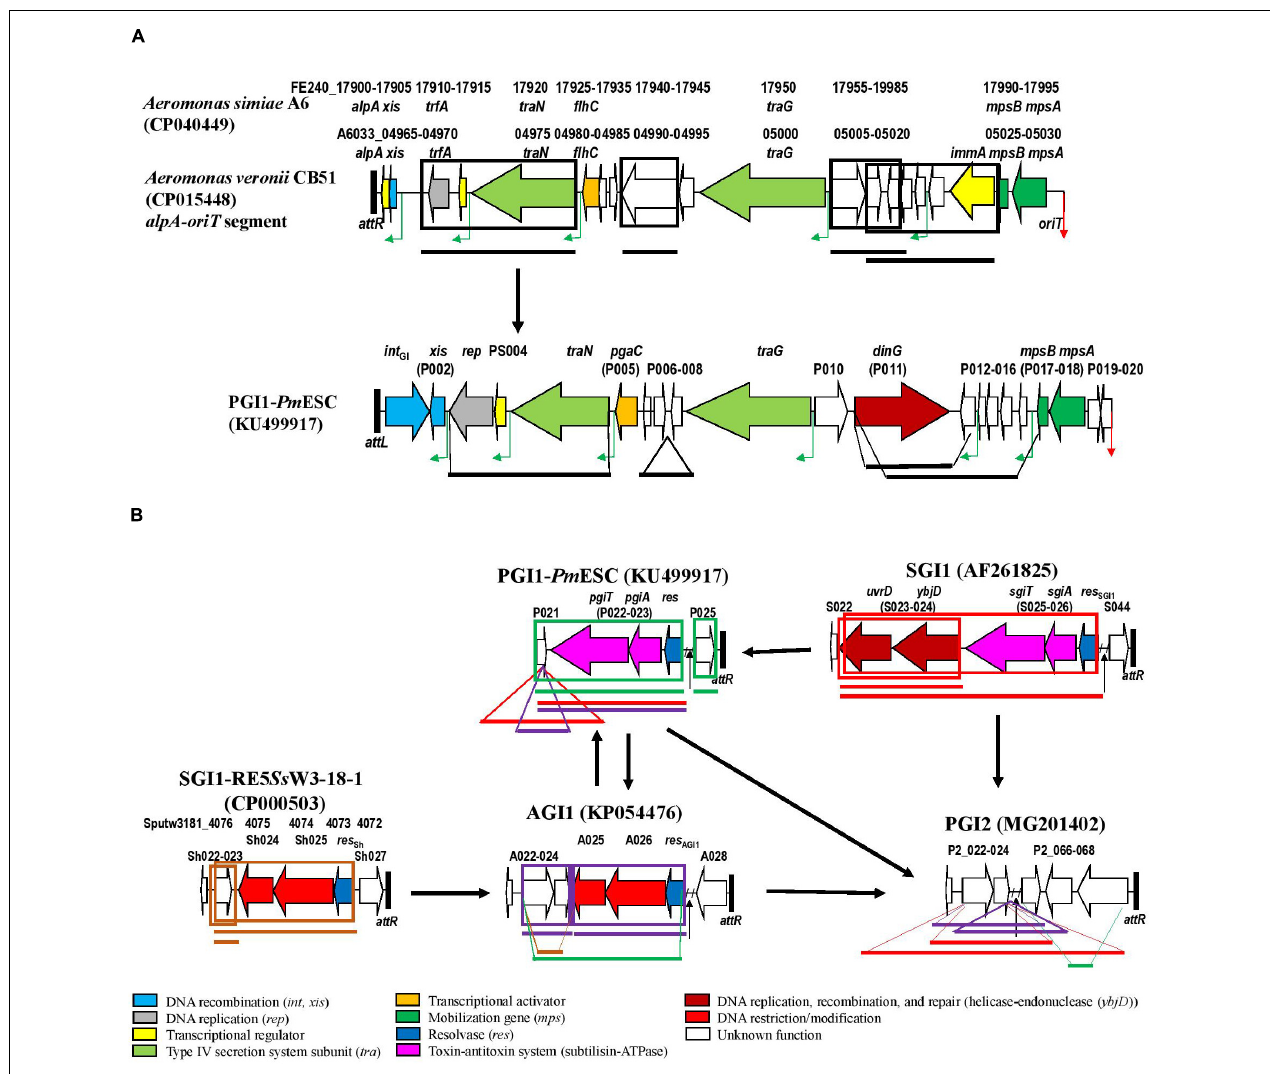
FIGURE 4 | Evolution of SGI1-REs by the insertion or exchange of parts of genetic elements from another GI family or from an SGI1-RE of another cluster. (A) In the first part of the SGI1-RE backbone. (B) In the second part of the SGI1-RE backbone. The ORFs of the backbone used as a reference are represented. The following colors are used for the ORFs of known function: light blue, DNA recombination ( int , xis ); gray, DNA replication ( rep ); yellow, transcriptional regulator; light green: type IV secretion system subunit ( tra ); orange, transcriptional activator; dark green, mobilization gene ( mps ); dark blue, resolvase ( res ); pink, toxin-antitoxin system (subtilisin-ATPase); dark red, DNA replication, recombination, and repair (helicase-endonuclease ( ybjD ); red, DNA restriction/modification; and white, unknown function. The green angled arrows indicate AcaCD binding sites, and the red arrow indicates origin of transfer ( oriT ). Black vertical lines represent attL and attR attachment sites. Regions of the GI that have been relocated are framed: black for yicC -targeting GI from Aeromonas , red for SGI1, green for PGI1, blue for PGI2, purple for AGI1, and brown for SGI1-RE5 Ss W3-18-1. Positions in the recipient GI are indicated by lines of the same size and color than in the donor.